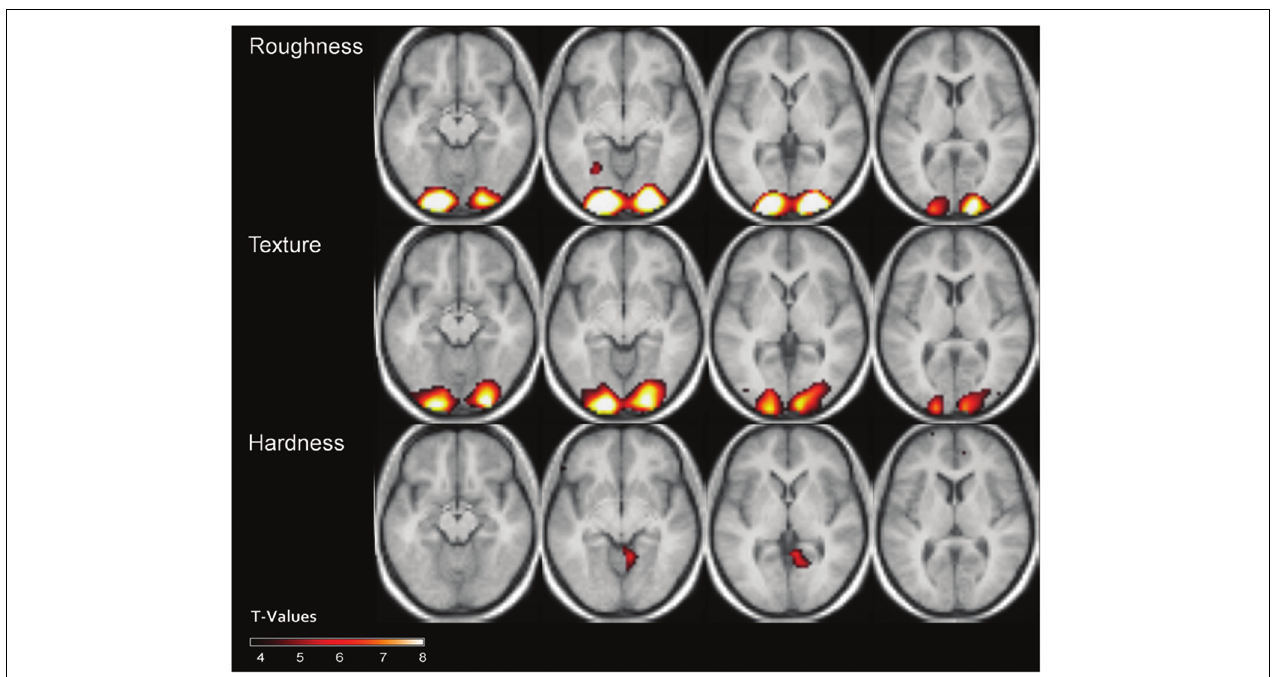
FIGURE 7 | Results of the whole-head searchlight classification procedure for the different properties [ t (14) = 3.79, p < 0.001]. Transverse slices at z = 7, 0, − 7 and − 14.